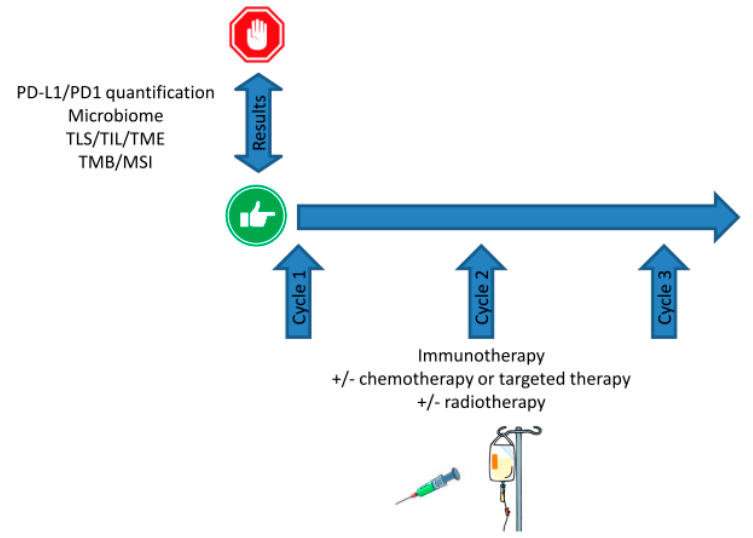
Figure 3. Current use of biomarker prior to setting up combinatorial immunotherapy. Upfront testing helps to determine the Go/No Go by predicting the odds of success. However, no longitudinal monitoring is currently feasible and basal levels have to be considered as granted.